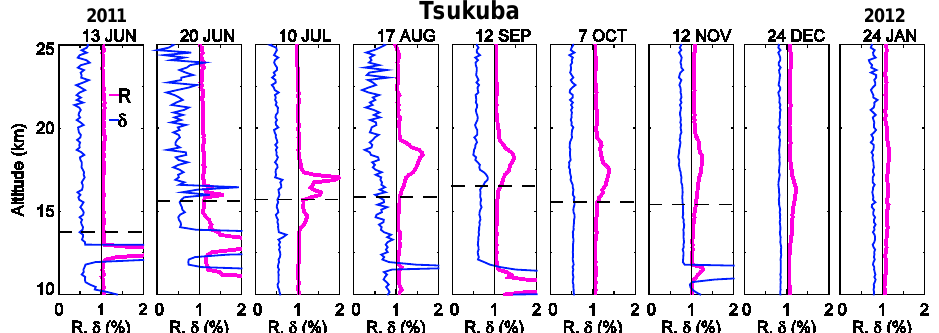
Fig. 1. Vertical profiles of the backscattering ratio R (pink line) and total depolarization ratio δ (%) (blue line) at λ 2 =532nm over Tsukuba from June 2011 through January 2012. Horizontal dashed lines show the first local tropopause heights. Large values of R and δ below tropopause heights are caused by cirrus clouds.